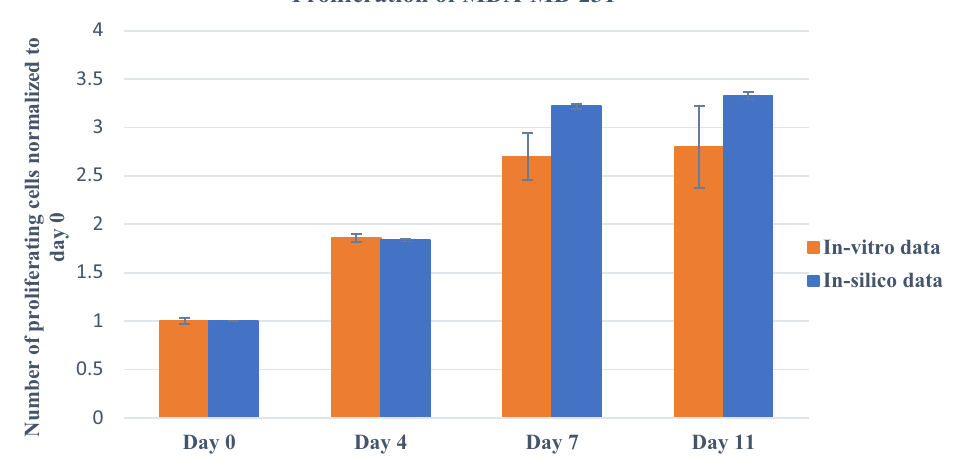
Figure 5. Comparison between in-vitro and in-silico results of MDA-MB-231 cell proliferation within the 3D hydrogel network. Error bars represent ± SD, n ≥